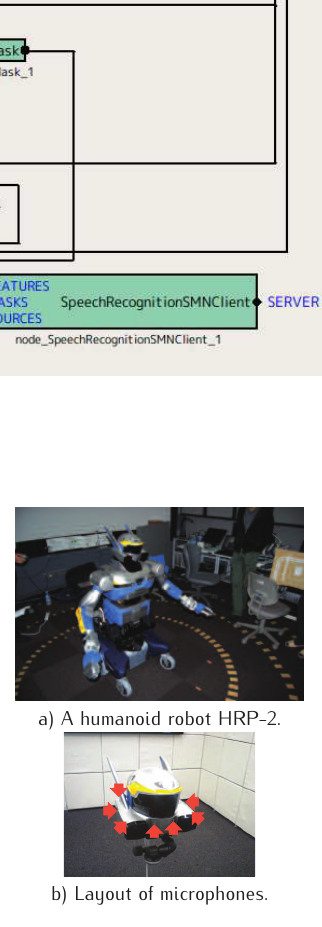
Figure 8. A humanoid robot HRP-2 with an 8ch microphone